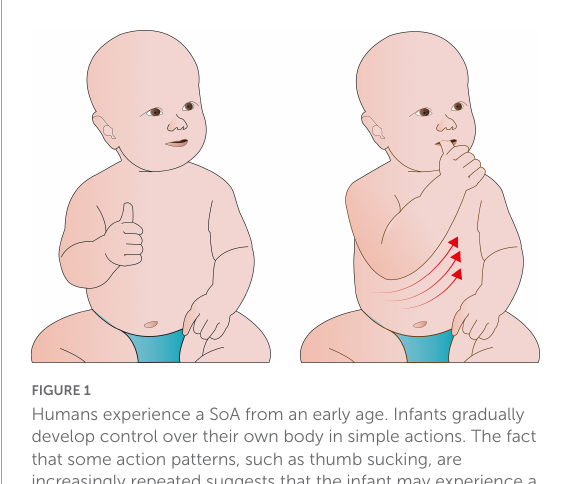
FIGURE1 Humans experience a SoA from an early age. Infants gradually develop control over their own body in simple actions. The fact that some action patterns, such as thumb sucking, are increasingly repeated suggests that the infant may experience a link between their control of the action and the rewarding sensation that the action produces.